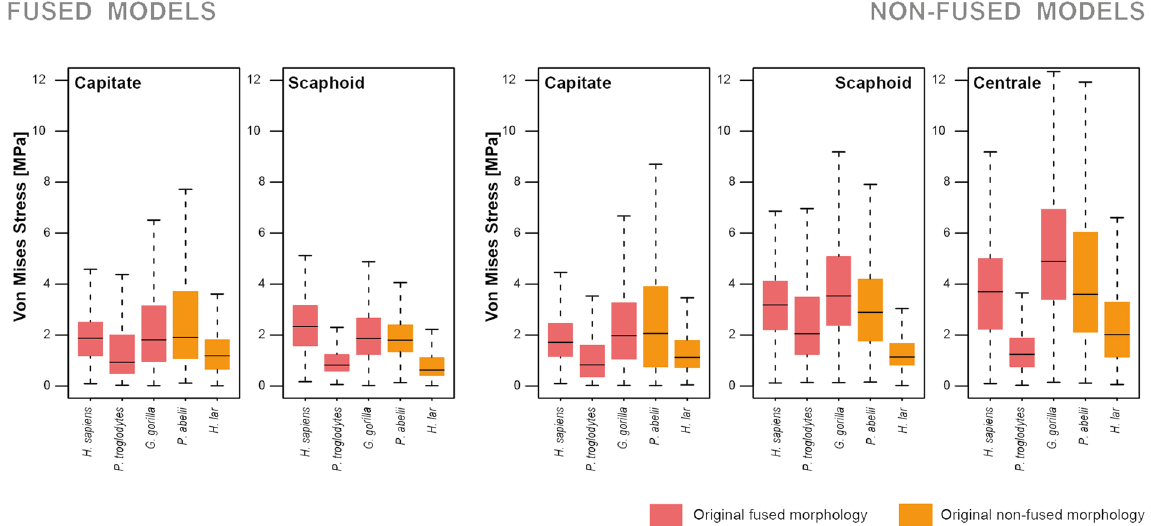
Figure 3. Boxplots of the stress distribution for both the fused and non-fused morphologies for all the species under analysis. The summary statistics used to create the boxplot are the median of the data (line), the lower (25%) and upper quartiles (75%) (box limits) and the minimum and maximum values